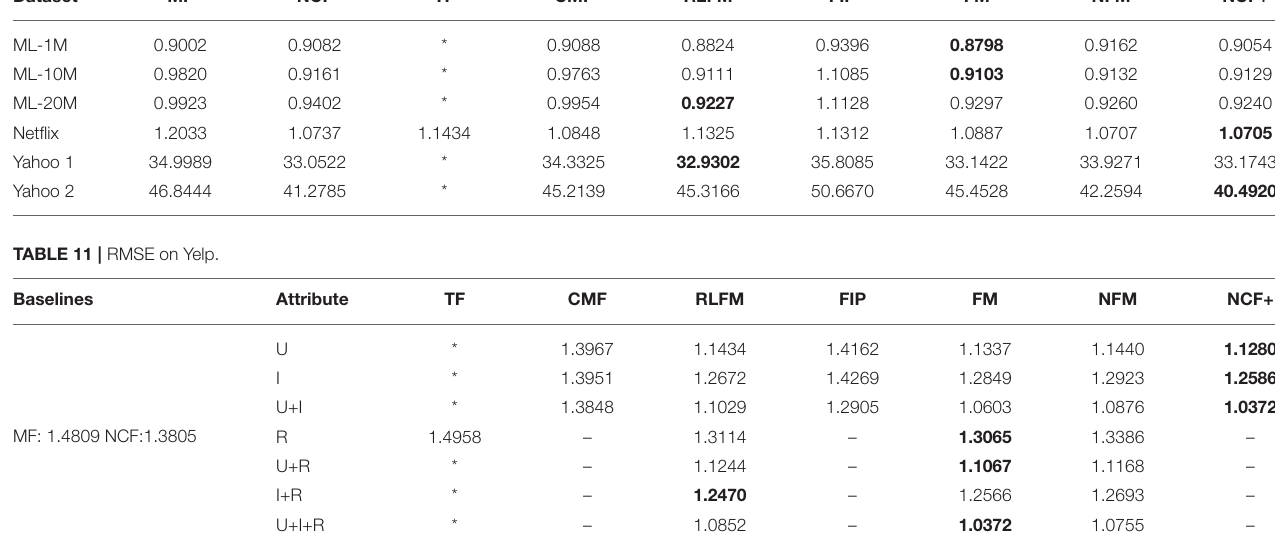
TABLE 10 | RMSE on all datasets except Yelp. Dataset